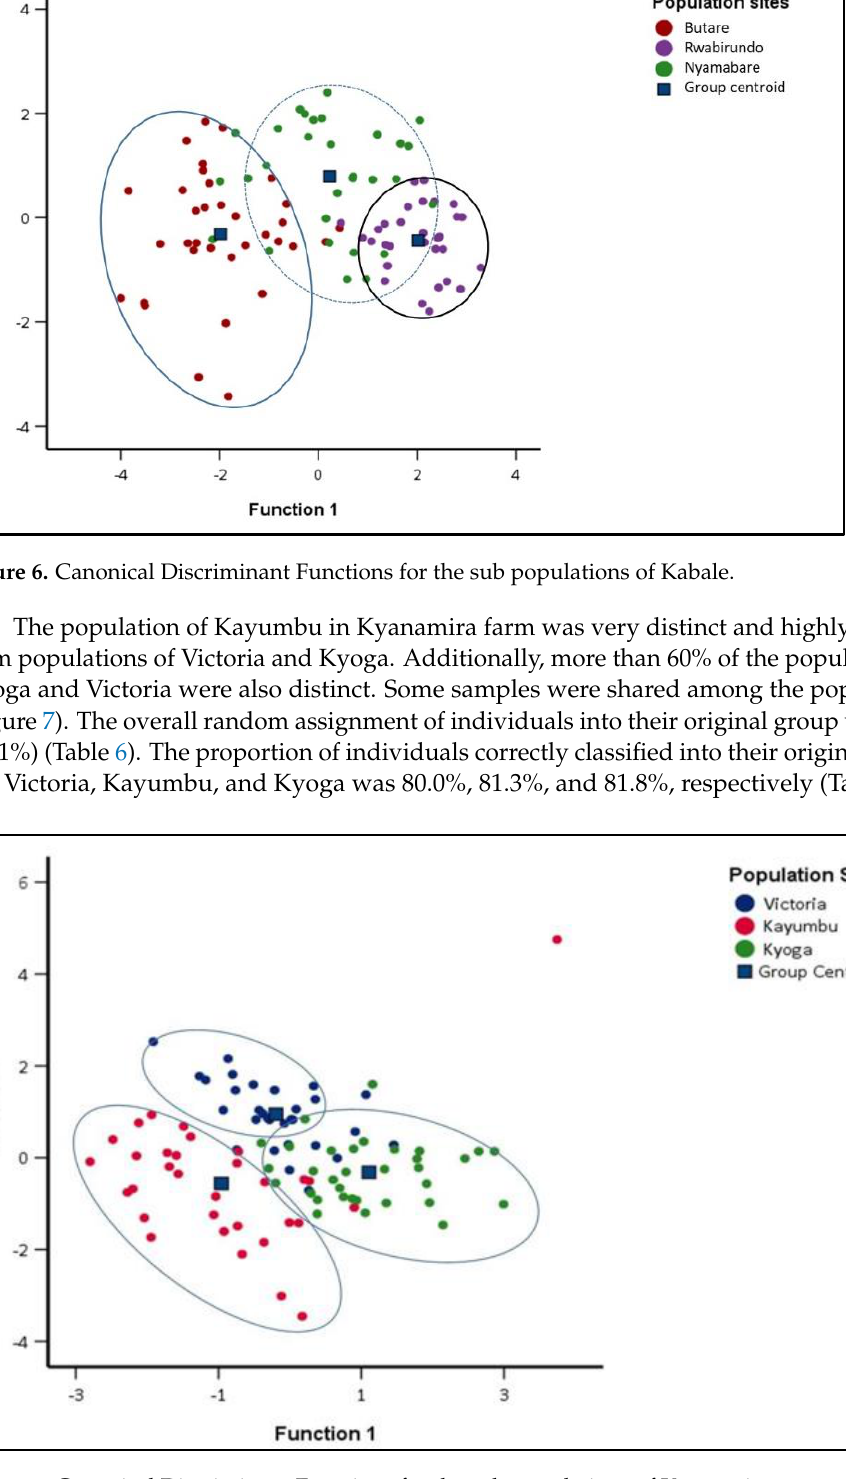
Figure 7. Canonical Discriminant Functions for the sub populations of Kyanamira. Table 6. Classification Results of Kyanamira sub populations.